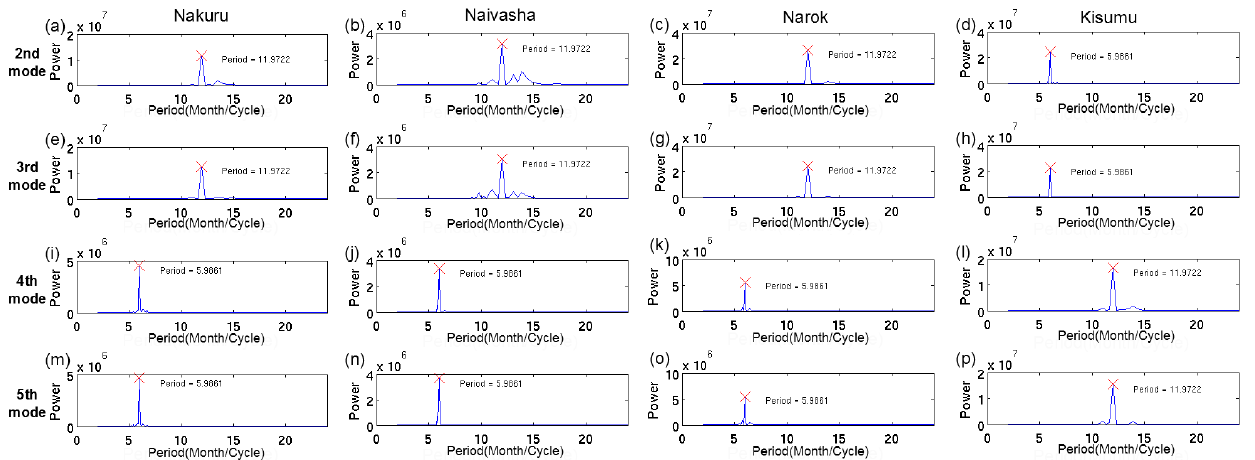
Fig. 18. Periodicities of the extracted harmonics components shown in (e)–(t) of Fig. 17. (a), (e), (i), and (m) for Nakuru. (b), (f), (j), and (n) for Naivasha. (c), (g), (k), and (o) for Narok. (d), (h), (l), and (p) for Kisumu. The two different periodicities are estimated, which are about the annual cycle (12 months) and the semiannual cycle (6 months).